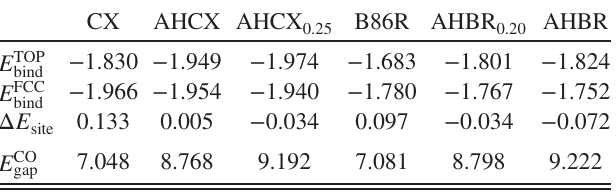
TABLE V. Comparison of TOP- and FCC-site CO = Pt ð 111 Þ , site-preference energies Δ E binding energies E bind site ¼ − E FCC E TOP , as well as molecular-gap results E CO (all in eV). gap bind bind The first and second blocks are for CX-AHCX and B86R-AHBR, respectively. For both tool chains, we also illustrate the impact of the choice of the Fock mixing (as identified in the functional- label subscript). All results are provided for the CX-provided substrate lattice constant a 0 ¼ 3 . 929 Å, molecular structure, and adsorption-induced deformations. Experimental observations of CO adsorption find TOP-site adsorption with binding energy Δ E − 1 . 32 eV [208]. site ¼